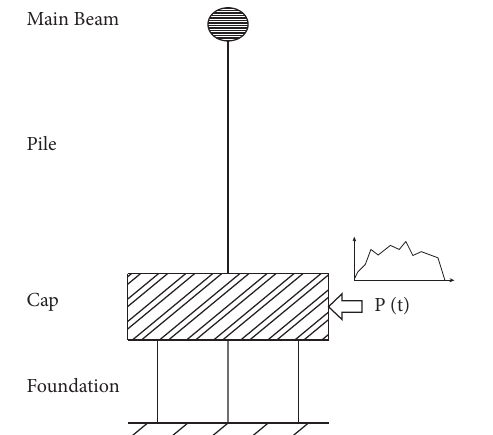
Figure 3: Forced vibration analysis model of vessel-bridge